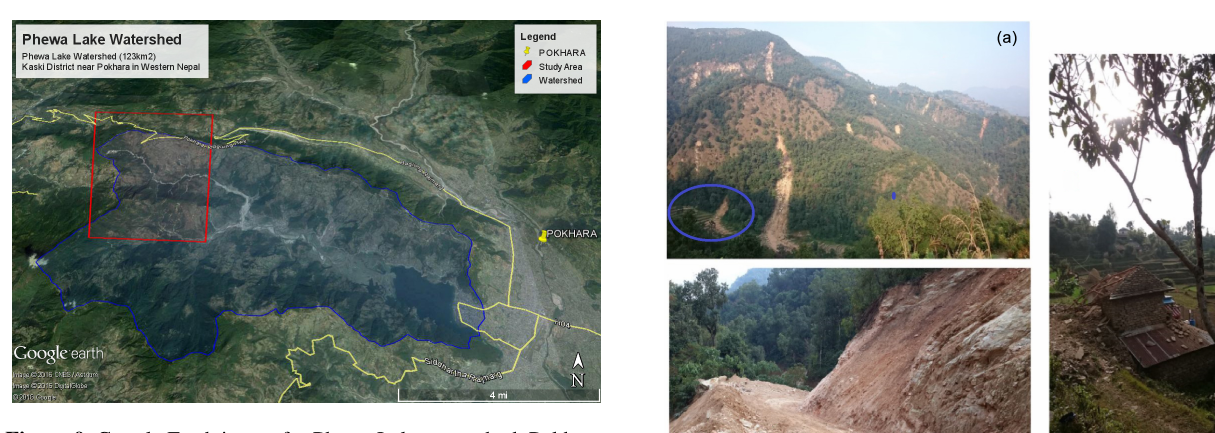
Figure 9. Google Earth image for Phewa Lake watershed, Pokhara, Nepal.